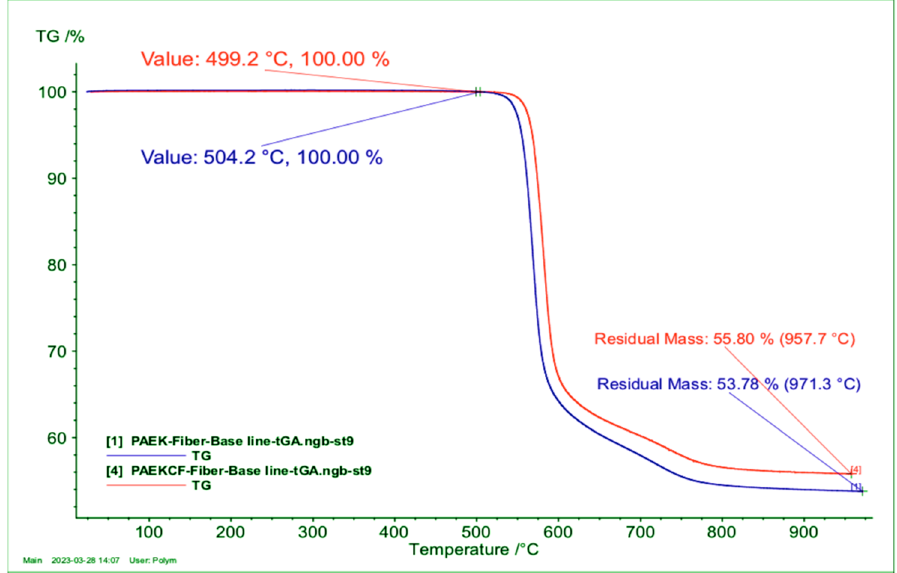
Figure 3. TGA curves of PAEK vs. PAEK/CF from 25 to 1000 C at 10 K/min in an inert